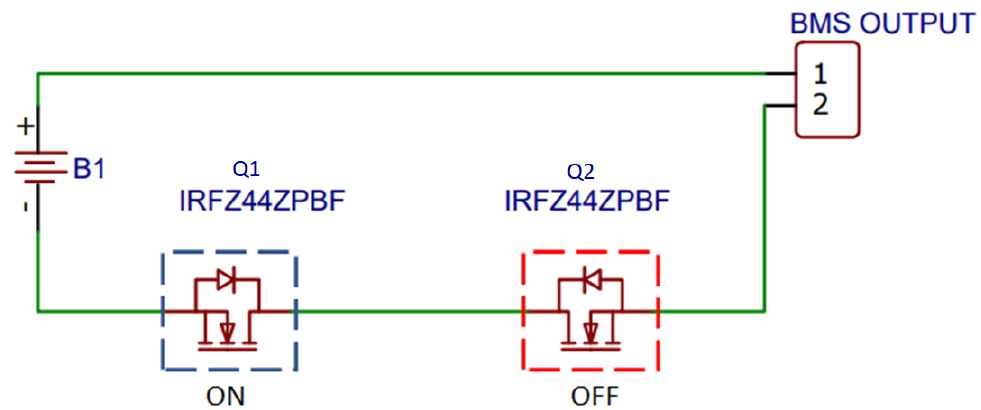
Figure 10. MOSFET in overdischarge